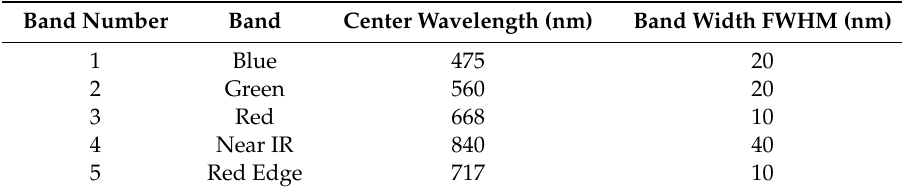
Table 2. Spectral bands of the Rededge-M.